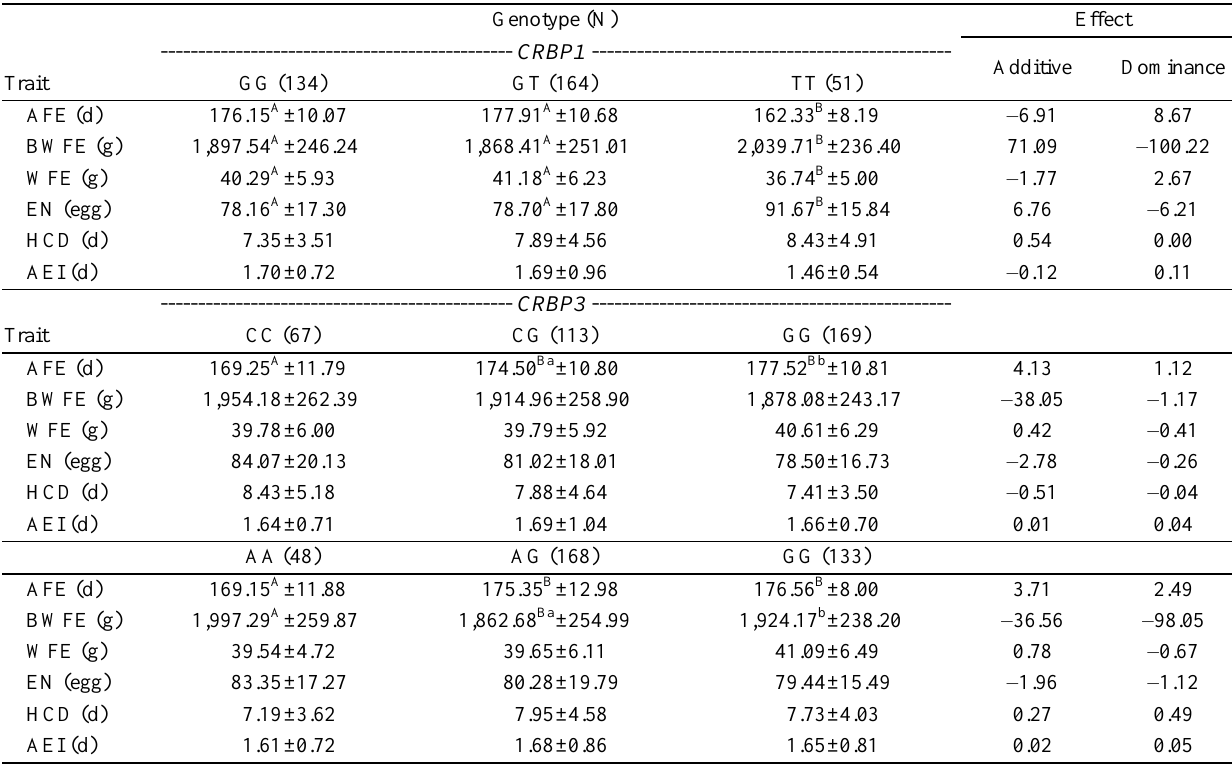
Table 3. Association of the SNP of CRBP1 and CRBP3 gene and laying performance traits Genotype (N) Effect Additive